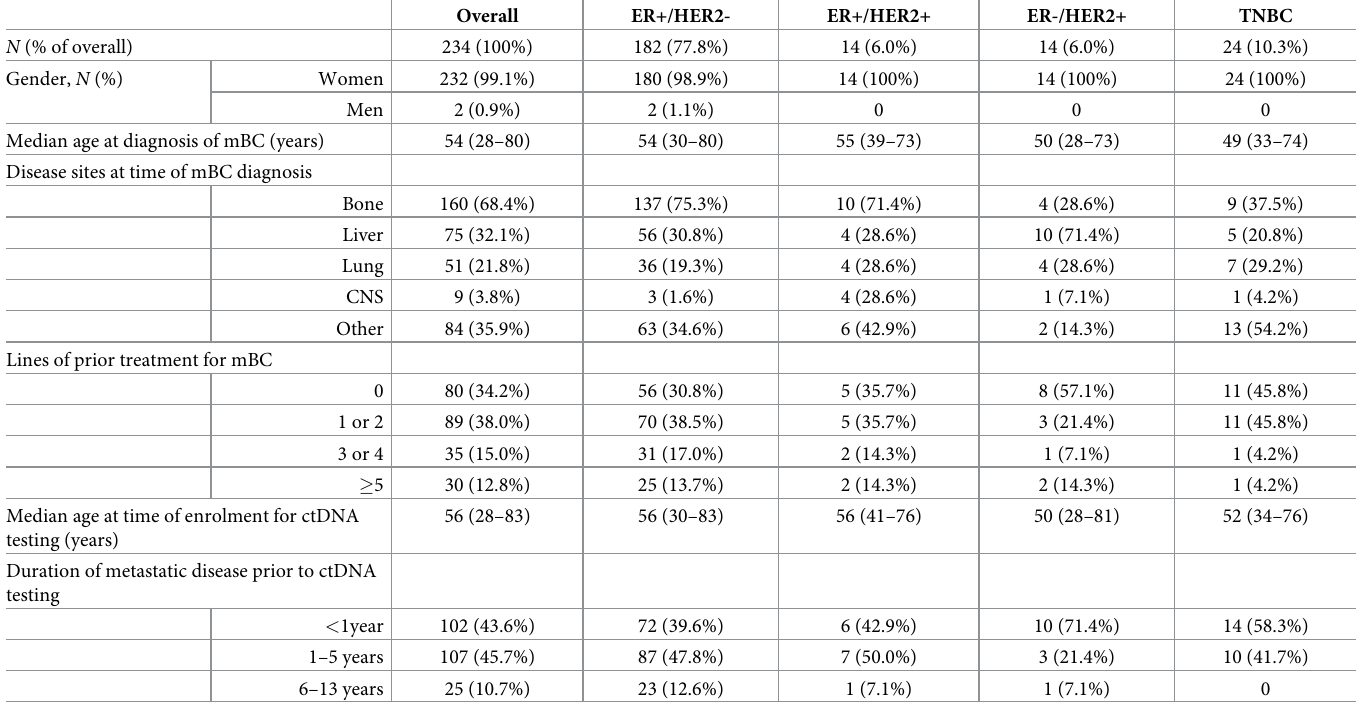
Table 1. Patient characteristics of the MBCB